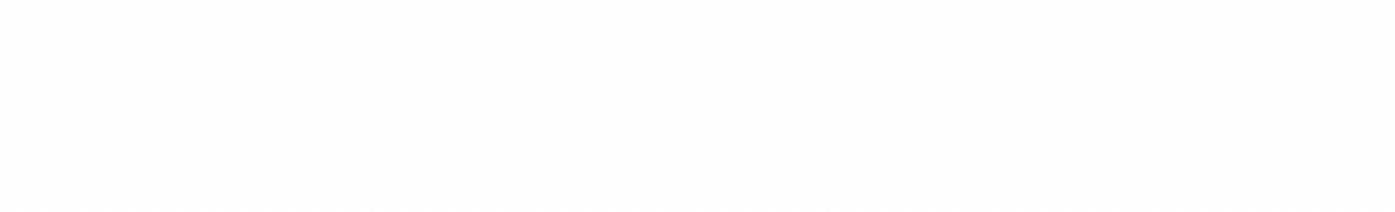
FIGURE Synchronization of the Henon map in the pre- sence of noise with W= 1. The noise in the form of random numbers are added to Xn(1), Xn(2), Y,(1) and Y,(2) at a fre- quency of 10 discrete time steps. The desynchronization peaks are seen at a regular time interval of 10 steps.